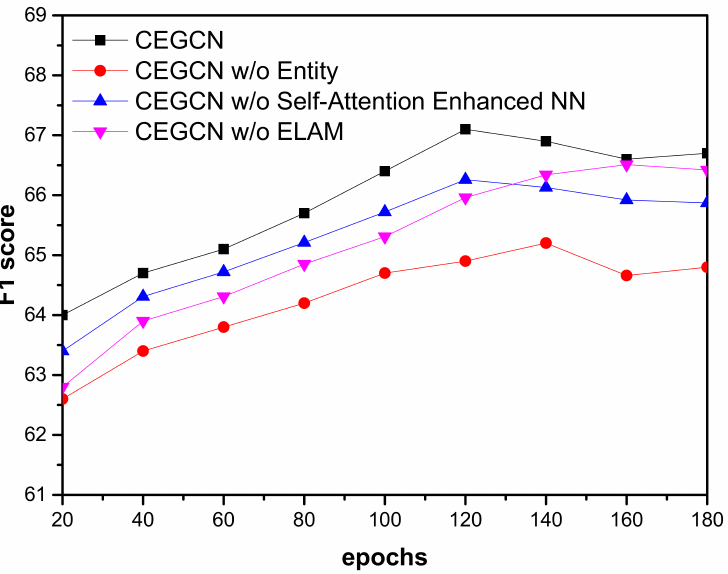
Figure 5. Experimental results in terms of F1 under different epochs for variant models of the abla- tion